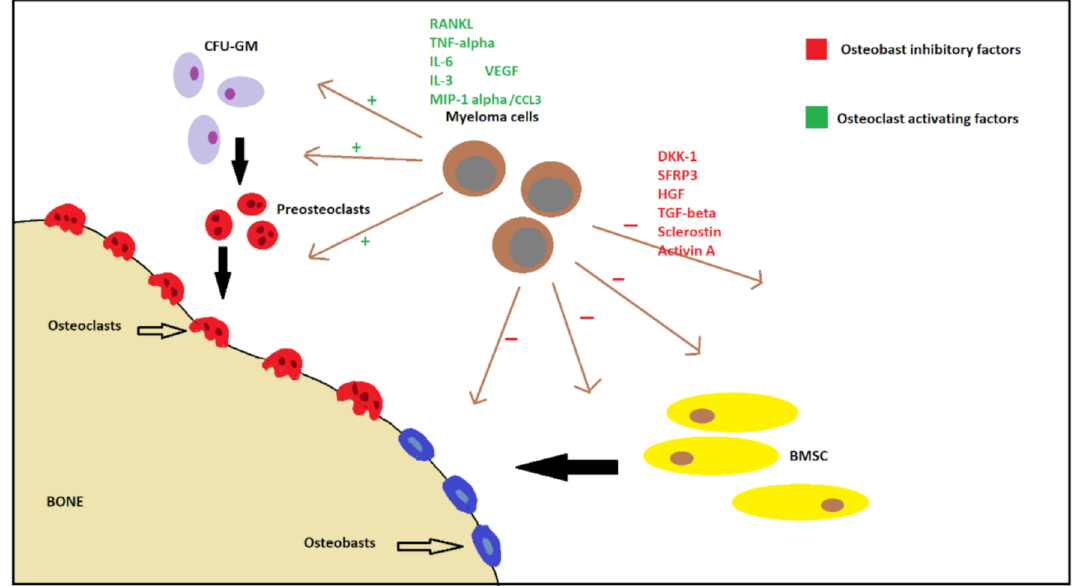
Figure 2. Mechanisms of myeloma-related bone disease. CFU-GM, colony forming unit—granulocyte/macrophage; RANKL, receptor-activated nuclear factor-kappa B ligand; TNF- α , tumor necrosis factor alpha; IL-6, interleukin-6; IL-3, interleukin-3; MIP-1- α (CCL3), macrophage inflammatory protein-1 alpha (C–C motif chemokine ligand 3); VEGF, vascular endothelial growth factor; DKK1, dickkopf WNT signaling pathway inhibitor 1; SFRP3, secreted frizzle related protein 3; HGF, hepatocyte growth factor; TGF- β , transforming growth factor beta; BMSC, bone marrow stromal